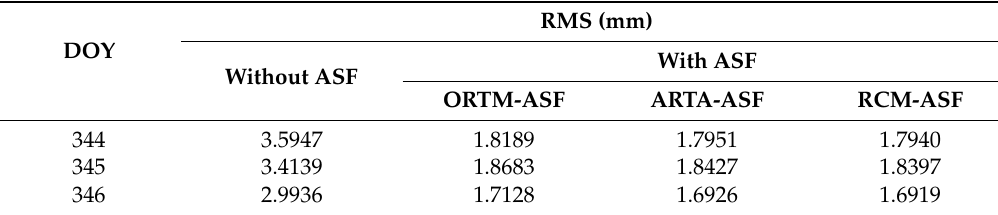
Table 3. RMS of residual time series for PRN 13.